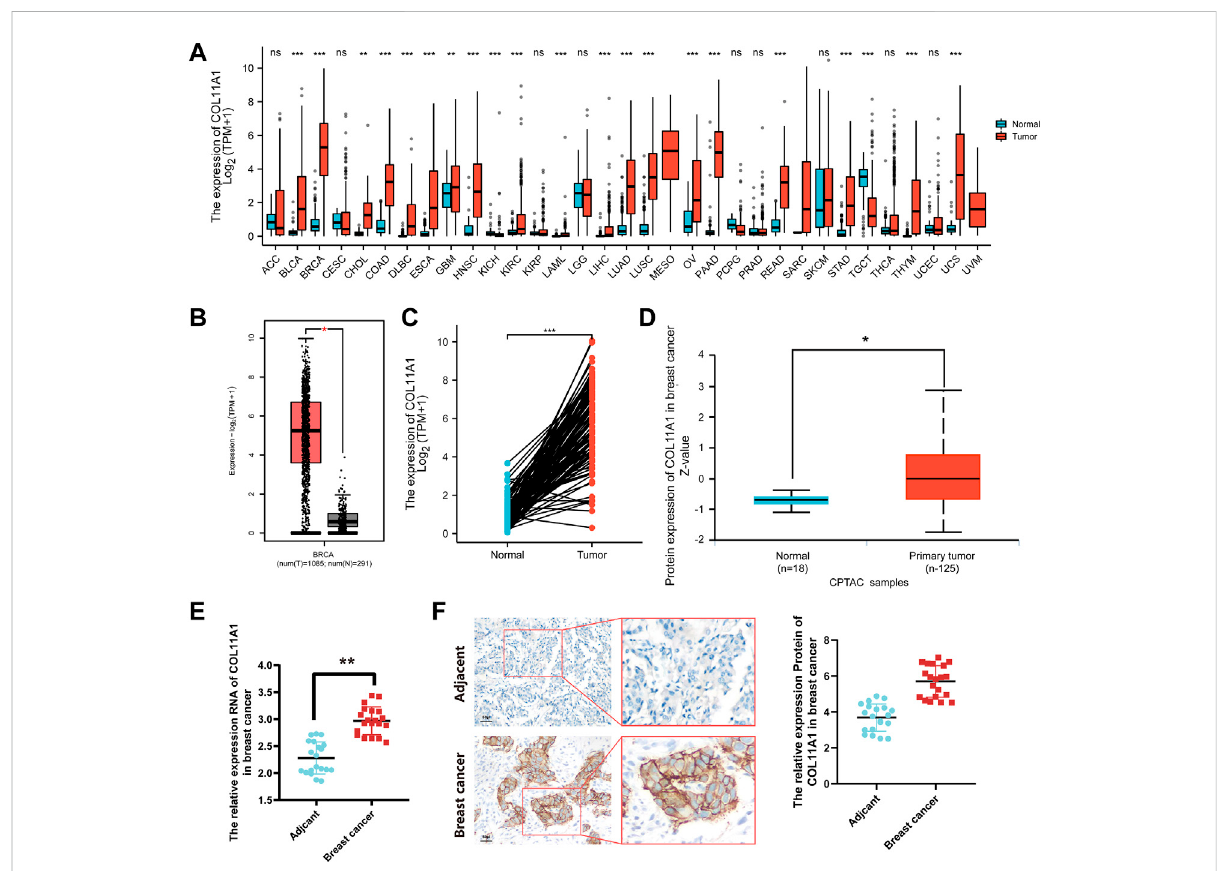
FIGURE 1 COL11A1 expression inbreastcancer. (A) The expressionof COL11A1 in different types of cancer was investigatedusing the TCGA database. (B) Increased expressionofCOL11A1 inbreastcancercomparedto normal tissues intheGEPIA2 database. (C) Statisticalanalysis of COL11A1 expression in TCGA database and 112 pairs of breast tissue and adjacent normal tissue. (D) The protein expression of COL11A1 in breast cancer was examined using the UALCAN database. * p < 0.05, *** p < 0.001. (E) RT-qPCR detection of COL11A1 transcript levels between breast cancer tissues and breast tissues. (F) Immunohistochemical staining was used to monitor COL11A1 protein levels between breast cancer tissues and breast